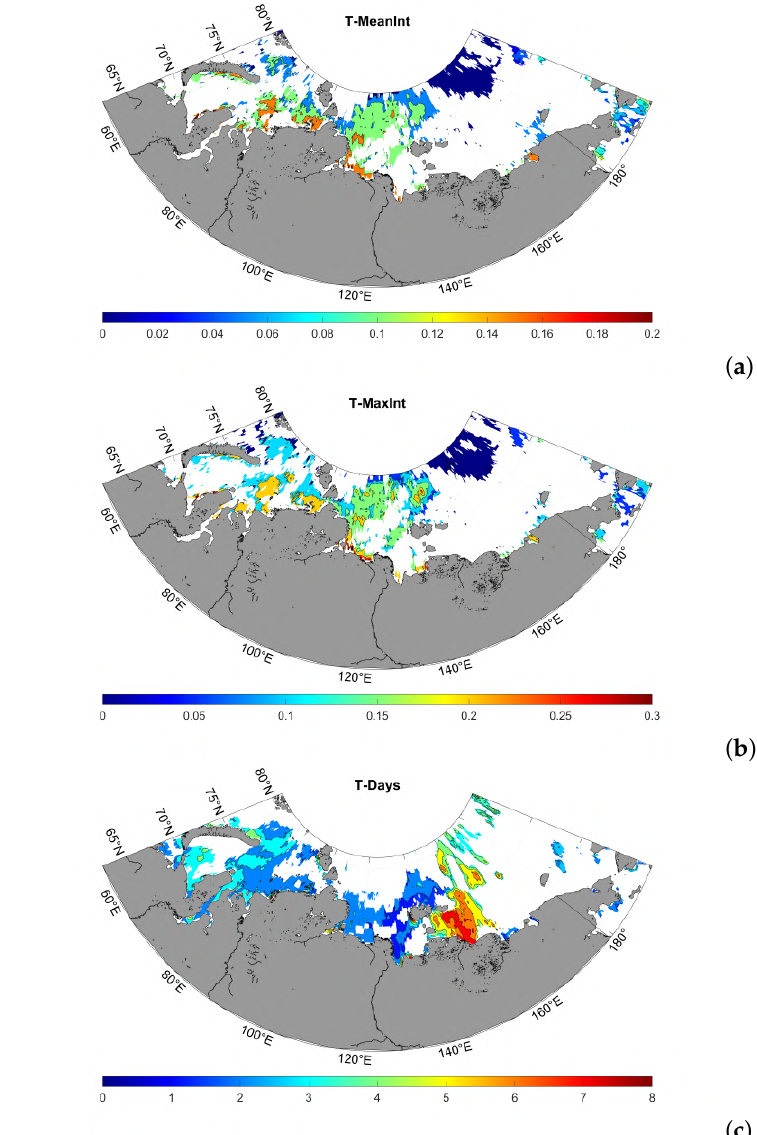
Figure 8. Linear trends of MHW characteristics in the Siberian Arctic seas based on data with eliminated linear trend: ( a ) mean intensity (in ◦ C), ( b ) maximum intensity (in ◦ C) and ( c ) total duration (in days) per year. White spaces denote areas lying beyond 95% confidence